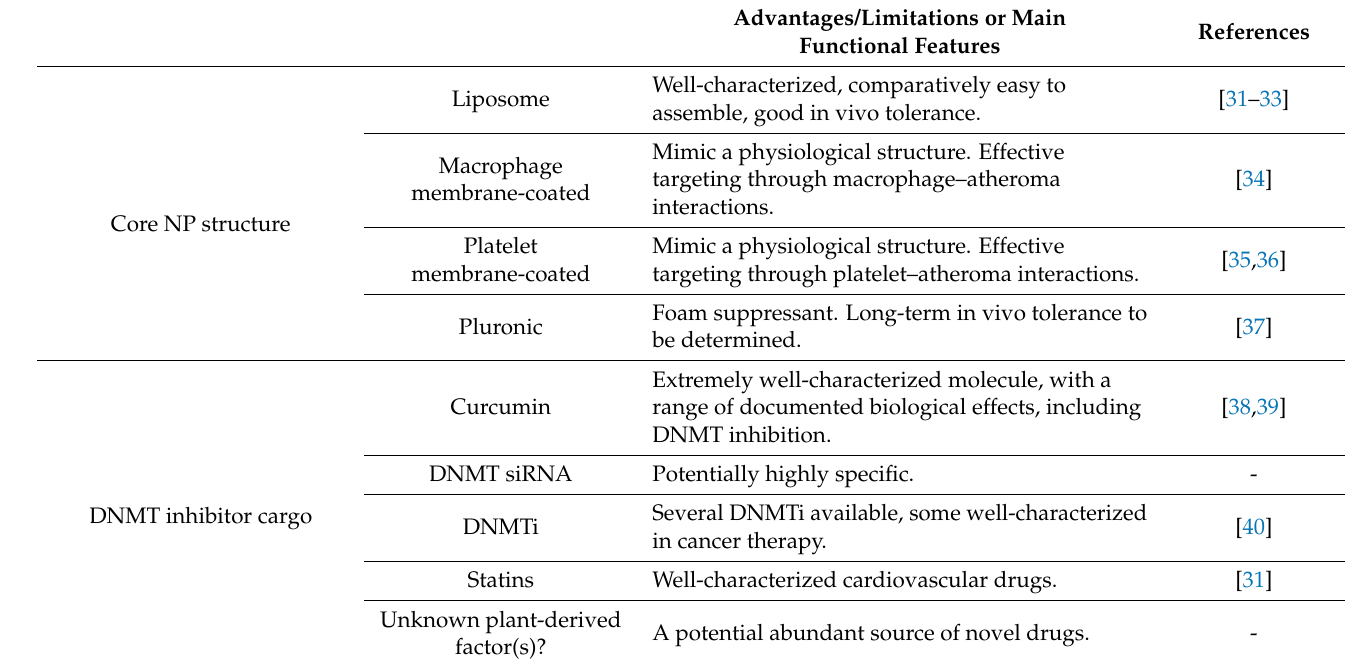
Table 1. Synopsis of candidate and tested NP delivery systems for DNA methylome targeting in